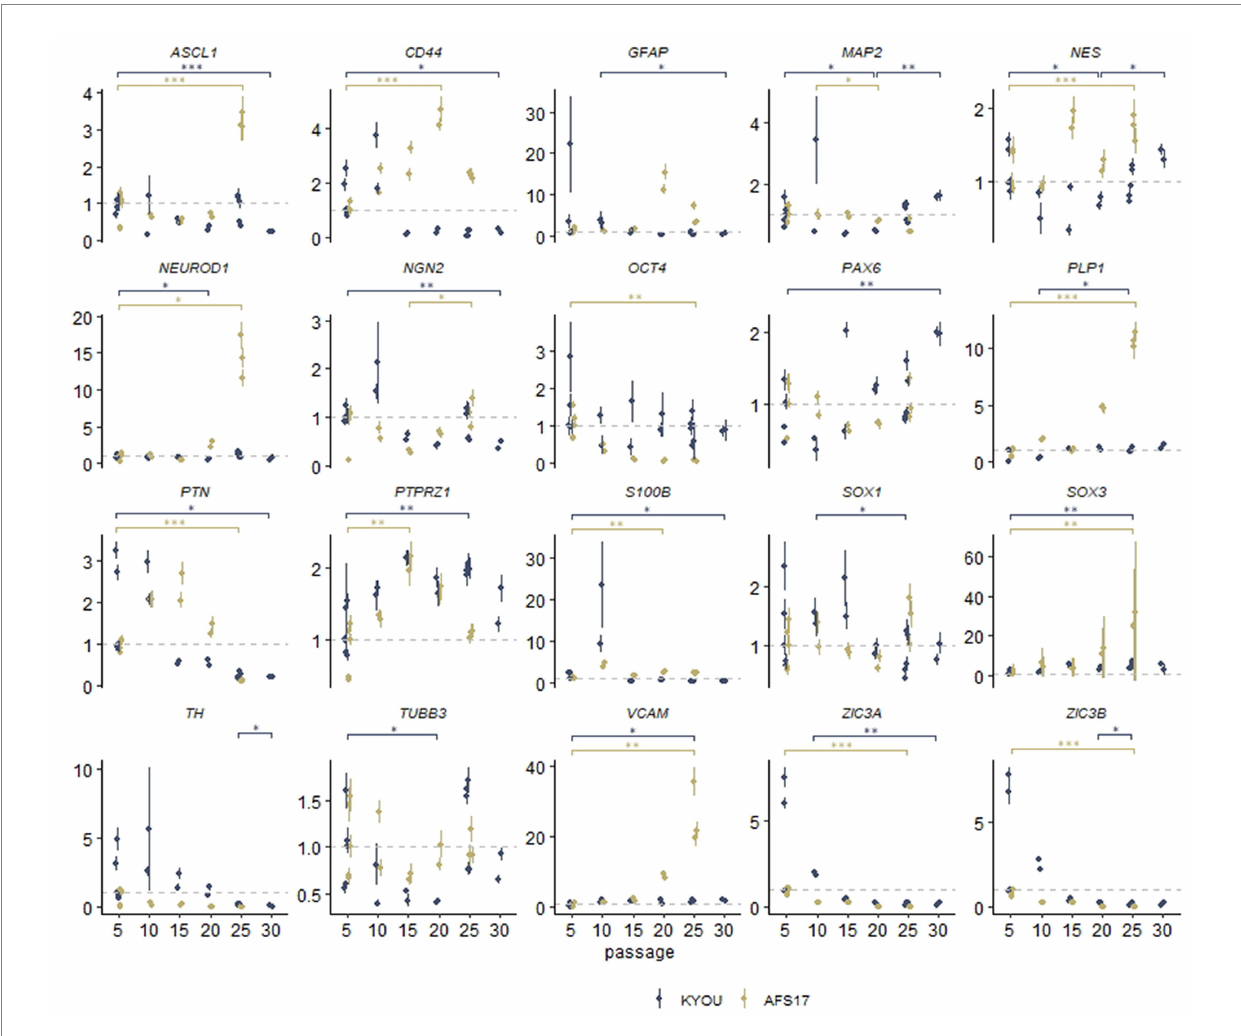
FIGURE 4 Results of quantitative RT-PCR analysis of the expression levels of marker genes in various neural cultures (N-KYOU and N-AFS17) obtained from the corresponding NSCs at passages 5, 10, 15, 20, 25, and 30 (for N-KYOU only). Along the y-axis is the expression level calculated by the −ΔΔ Ct method, normalized to the expression of housekeeping genes. Each dot represents a biological replicate collected separately at a different time point (N-KYOU p5–5 replicates, N-KYOU p10–2 replicates, N-KYOU p15–2 replicates, N-KYOU p20–2 replicates, N-KYOU p25–5 replicates, N-KYOU p30–2 replicates; N-AFS17 р 5–5 replicates, N-AFS17 р 10–2 replicates, N-AFS17 р 15–2 replicates, N-AFS17 р 20–2 replicates, N-AFS17 р 25–3 replicates). The error bars indicate the standard deviation of the technical replicates, as determined by RT-qPCR. Asterisks indicate the statistical significance of